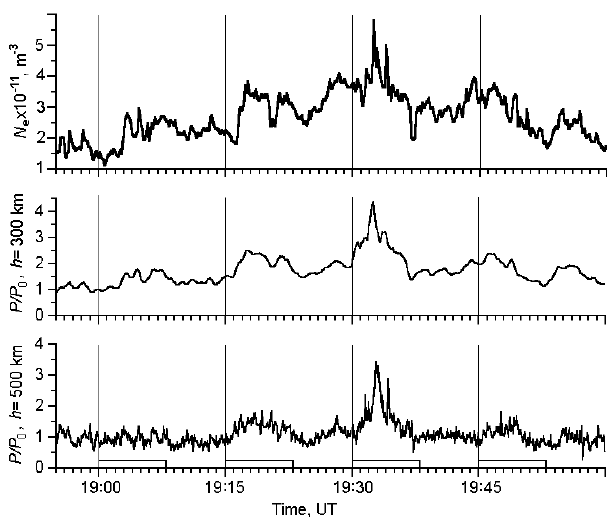
Figure 8. The temporal behavior of the electron density N e at the altitude of 300 km from the EISCAT UHF radar, relative values of partial pressure P / P 0 at the altitudes of 300 and 500 km in course of the Tromsø HF pumping experiments on 2 October 1998, from 18.55 to 20.00 UT. The intervals when the Tromsø heater was turned on are marked by bars on the time axis.